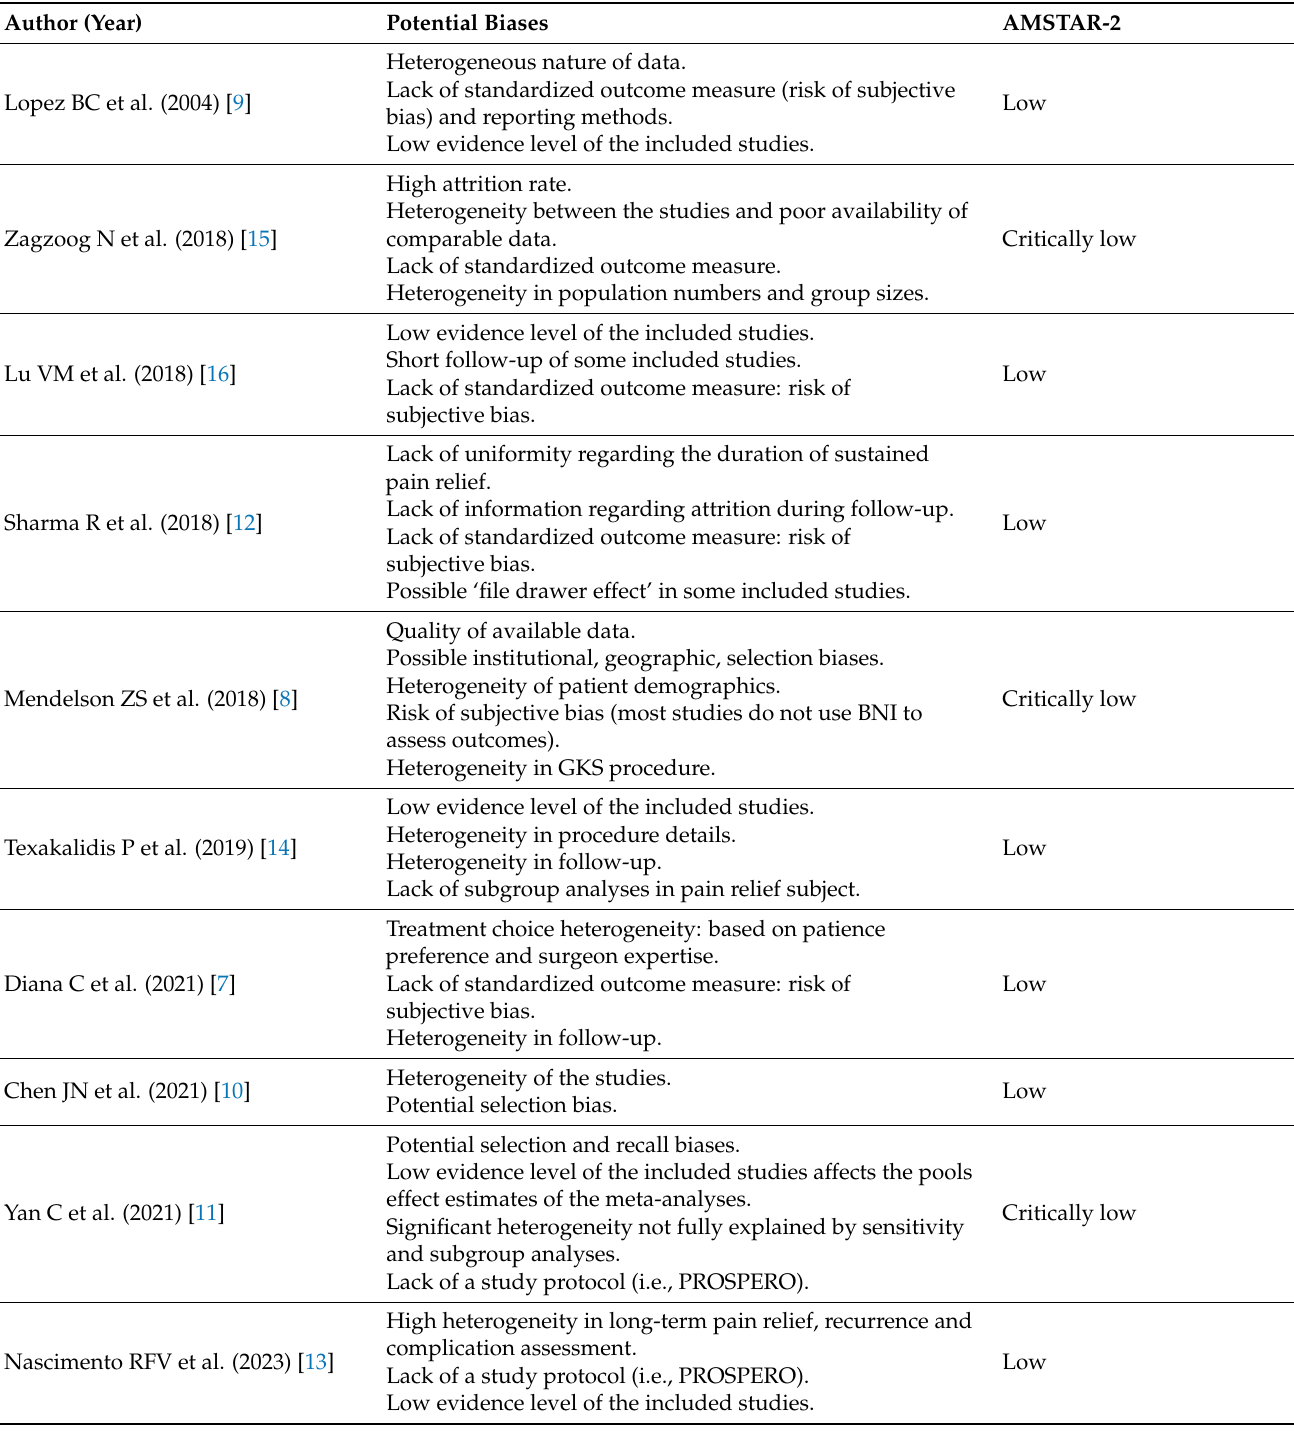
Table 2. Potential biases and level of evidence (AMSTAR-2) of the 10 studies included in this umbrella